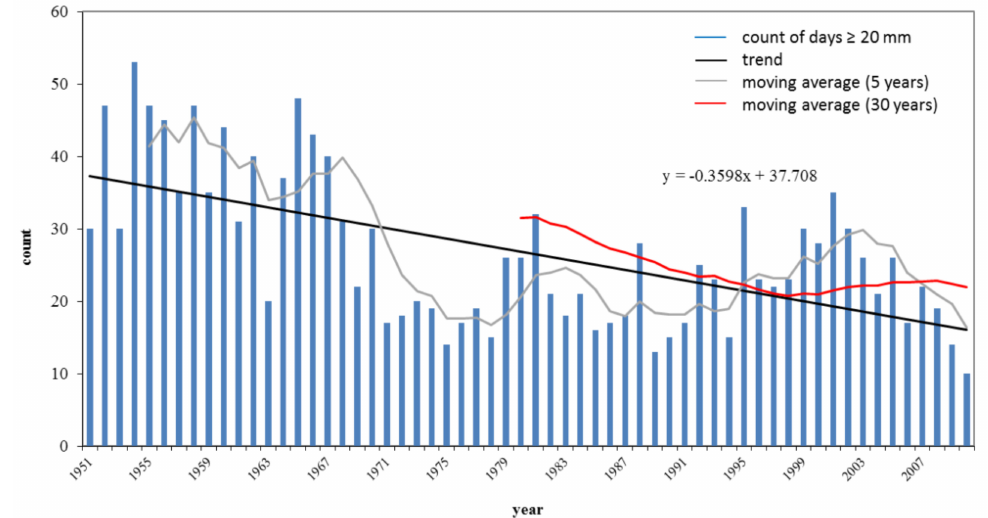
Figure 9. Frequency of rainfall days with ≥ 20 mm and trend at station Wendelstein (1951–2012),